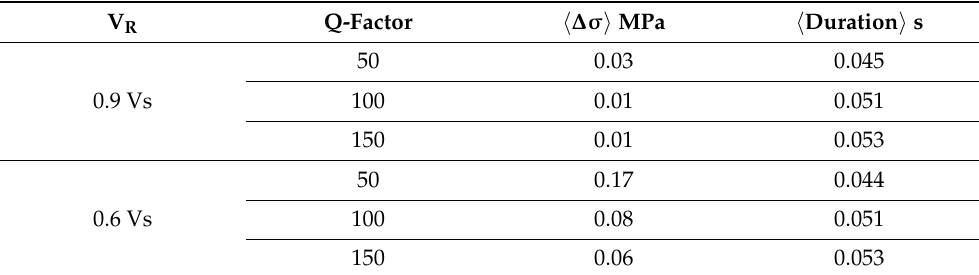
Table 1. Two different values of rupture velocity and three different values of Q have been tested to show changes in the average stress release value and in the average duration obtained from T c